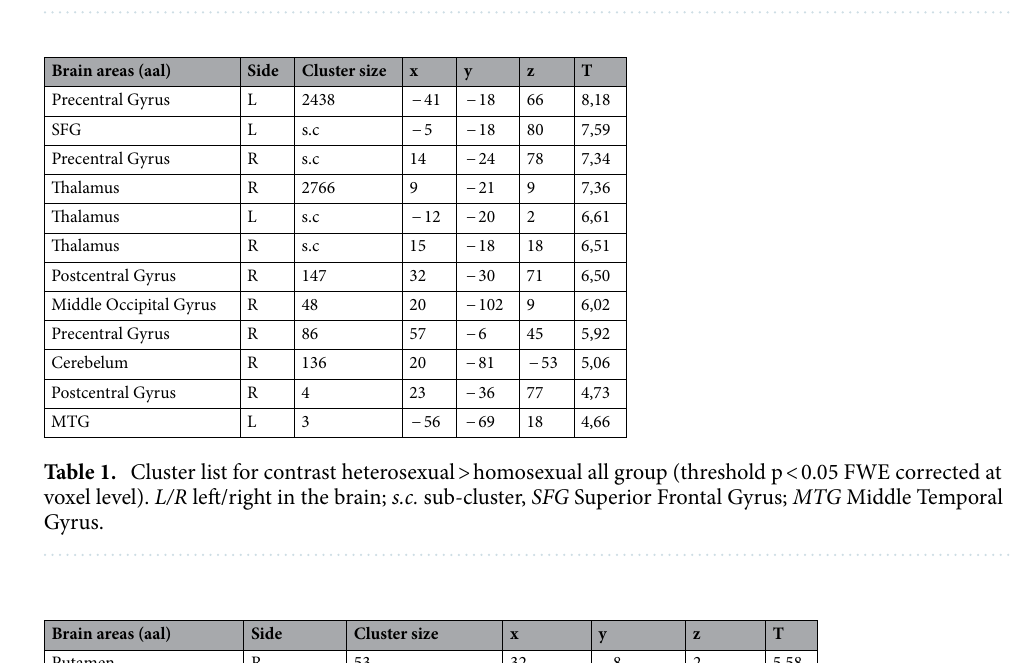
Figure 1. Whole-brain v-FWE corrected VBM analyses for the entire sample.